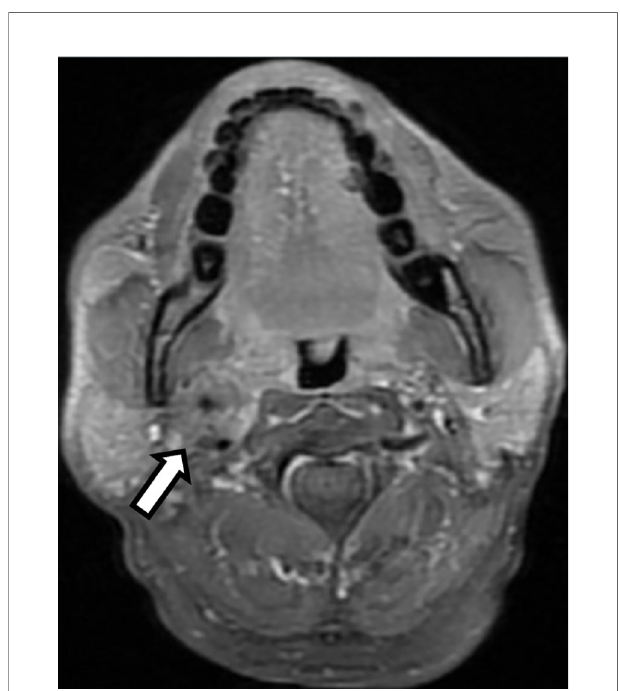
FIGURE 1 | T1-weighted head and neck magnetic resonance image (MRI) with fat saturation revealed a 2.6 centimeter enhancing soft tissue lesion occupying the right carotid space and the right parapharyngeal space at the level of carotid bifurcation with right internal and external carotid artery encasement (Open